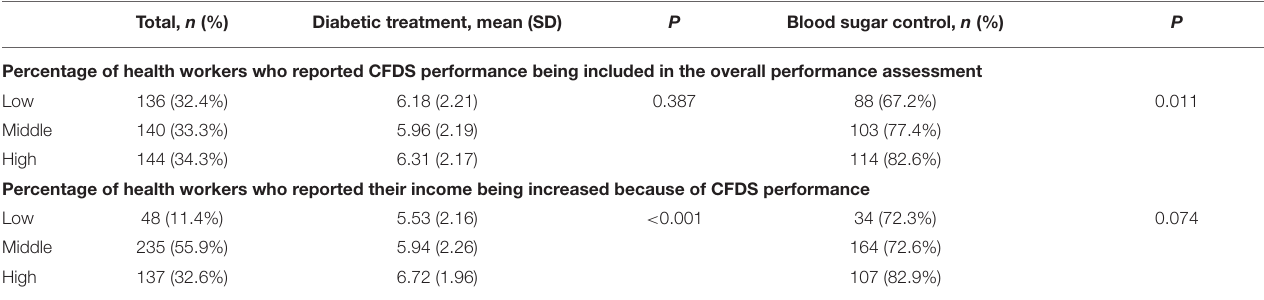
Total, n (%) Diabetic treatment, mean (SD) P Blood sugar control, n